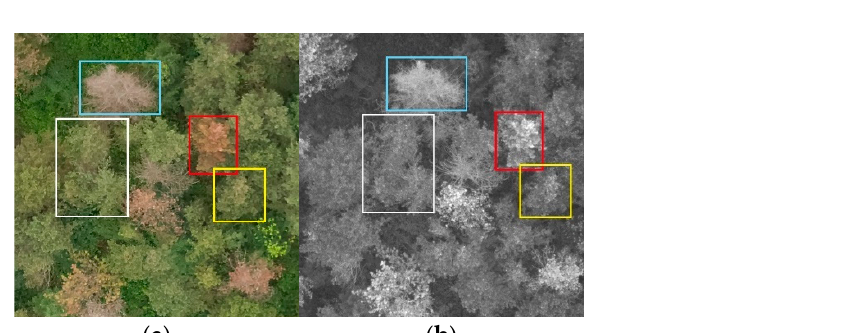
Figure 2. Sample images collected by the multispectral UAV: ( a ) Visible image, ( b ) red-band image.